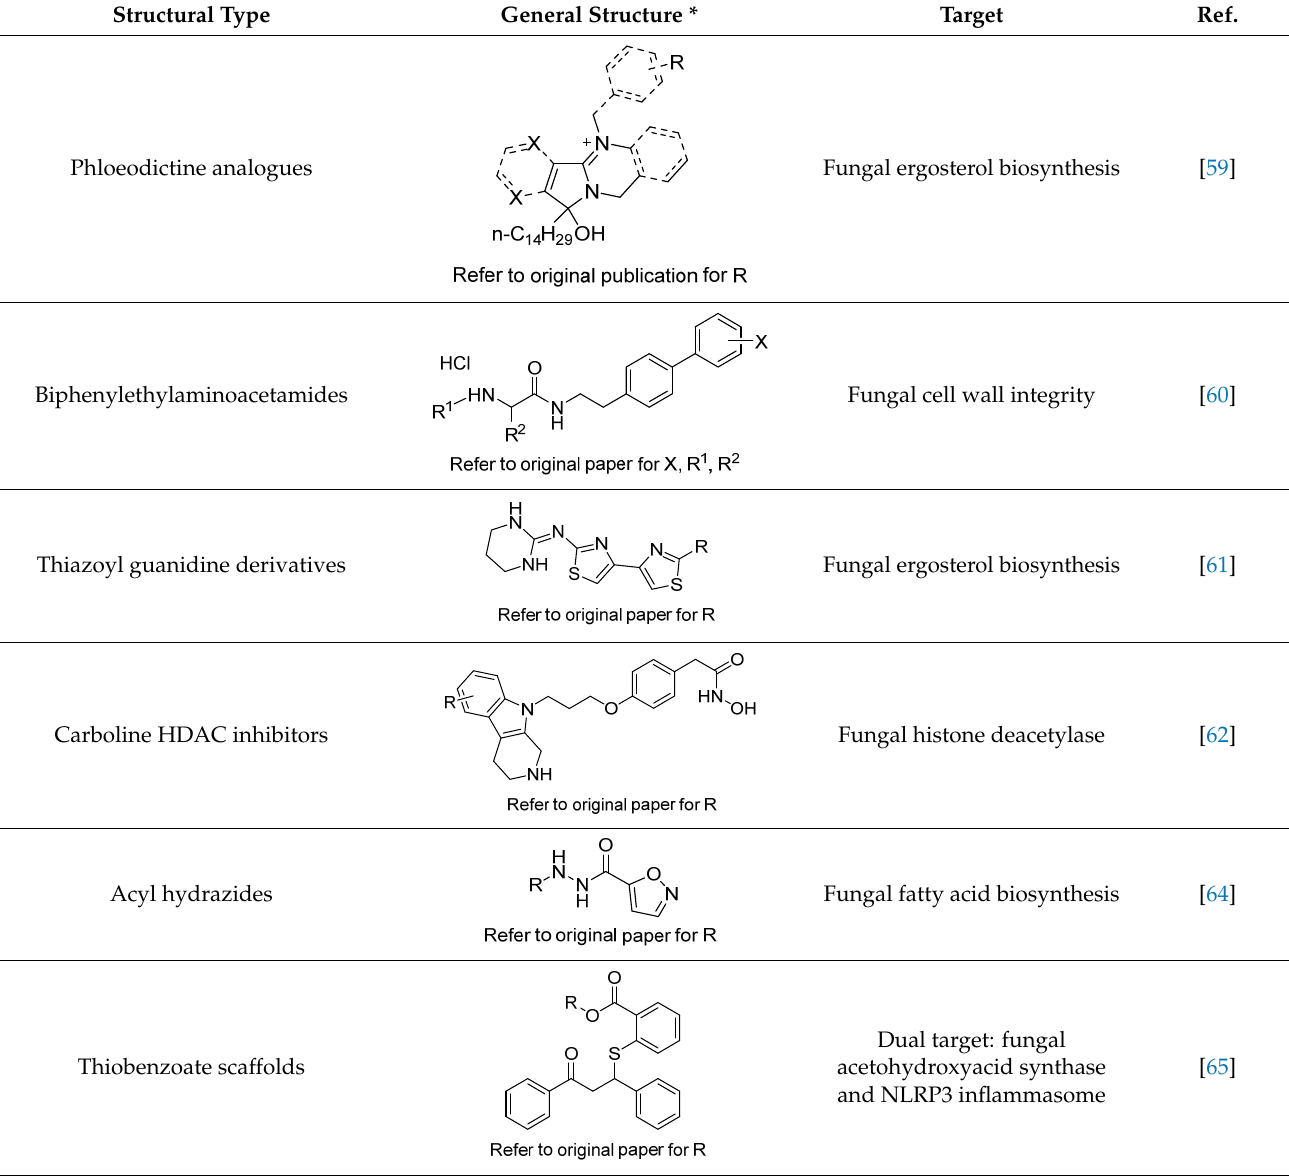
Table 2. The general structures of some of the most recent (published in 2021), successful synthetic efforts from academia. Structural Type